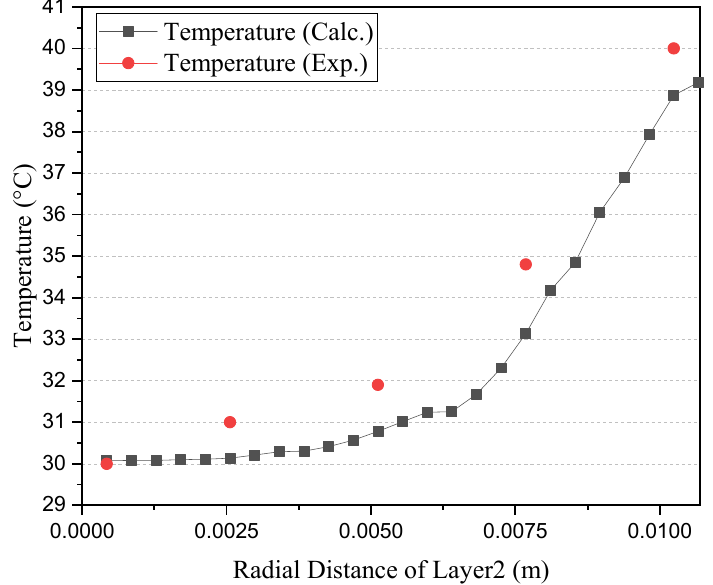
Figure 13. Comparisons of calculated (Calc.) and experimental (Exp.) temperature distributions of Layer 2 for the DN pulley (76.2 mm) under a rotation speed of 4000 RPM and T pcn = 55 ◦